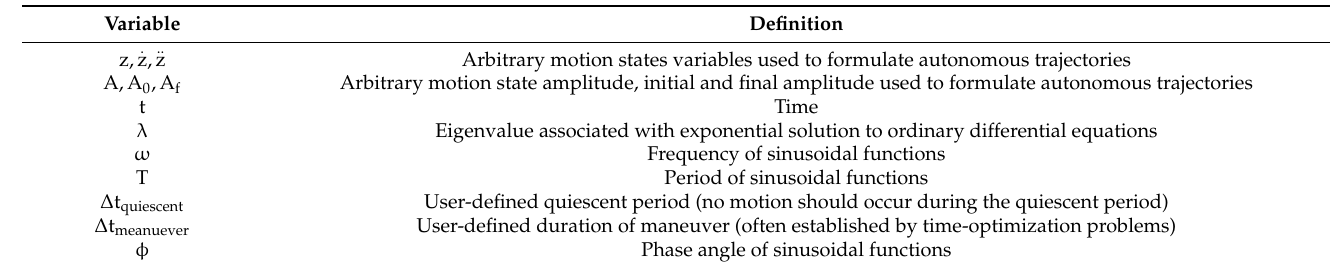
Table A1. Table of variable definitions for Section